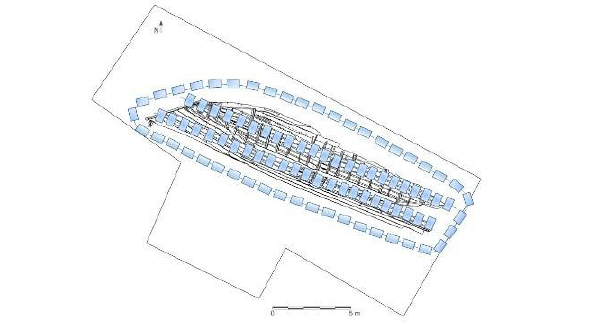
Figure 4. Disposition of the camera shooting